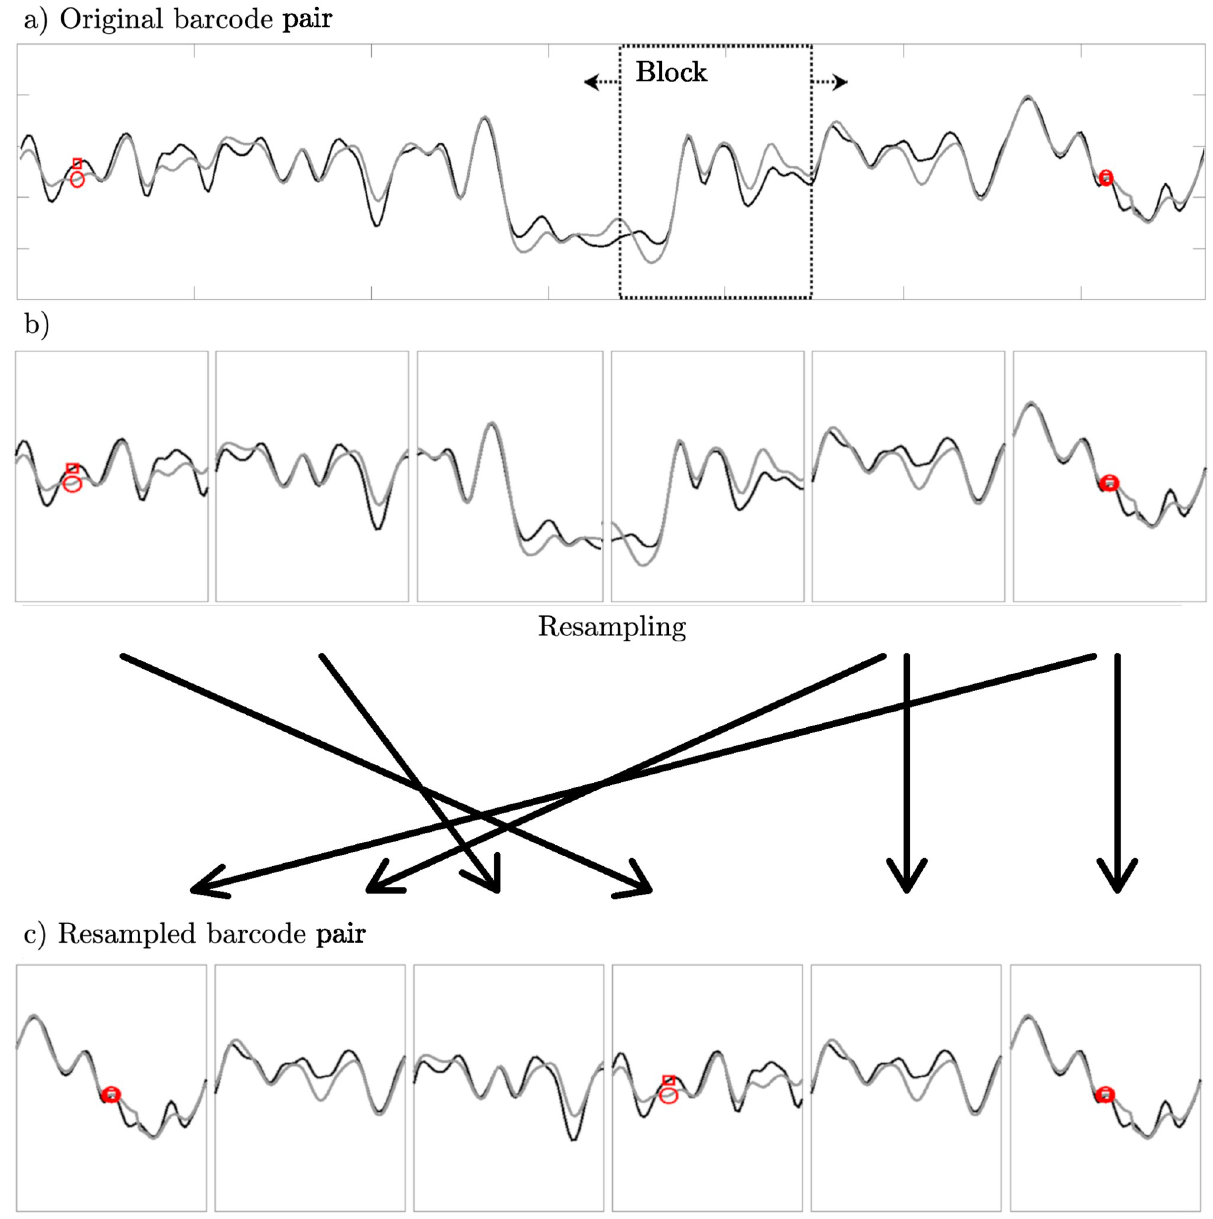
Fig 3. Resampling of a top-matching dually labeled barcode pair using the block-bootstrap method. The goal, as described in Sec 2.5, is to estimate the variance in the match-score of a top matching database plasmid. (a) The top-matching experimental barcode and the optimally aligned theoretical barcode are divided into blocks of equal size. (b) The blocks are sampled with replacement (see sec 2.5) and glued together into (c) a resampled barcode pair. The resampled barcode pair is used as if it were a variation of the original barcode and to calculate a new match-score. This can be repeated as many times as necessary to produce a set of resampled match scores. From this set, we calculate a sample estimate of the match-score variance for the top case. In the present study, we choose to generate 1000 resampled barcode pairs. Note that the blocks in the figure are larger than the ones used in practice for visual